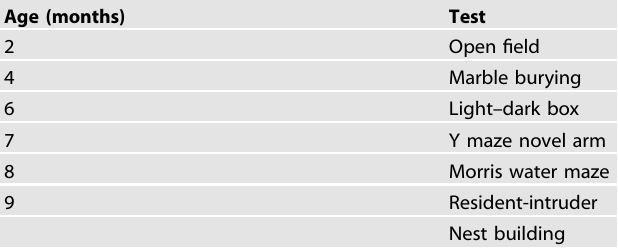
Table 1. Age distribution of mice for behavioral